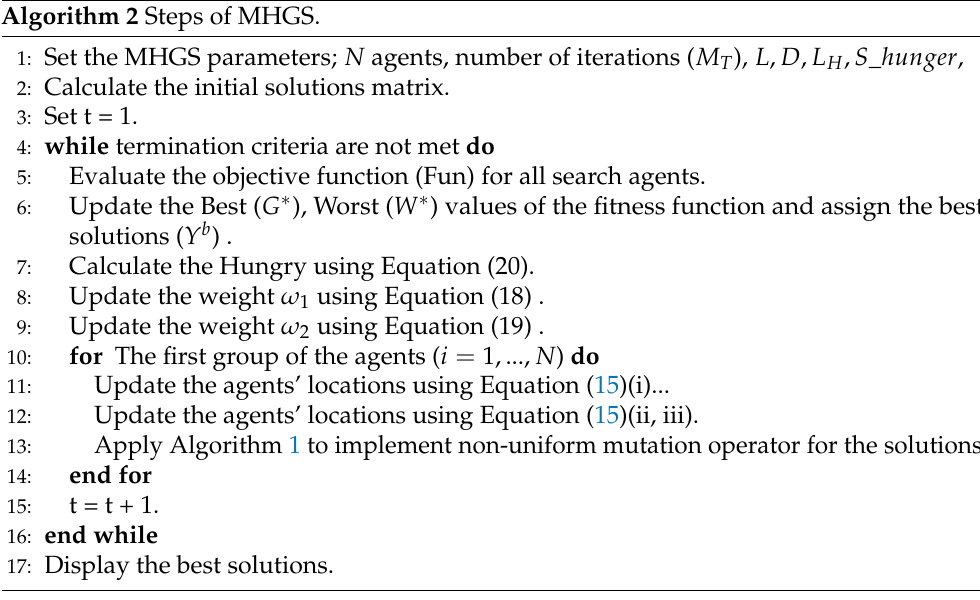
Apply Algorithm 1 to implement non-uniform mutation operator for the